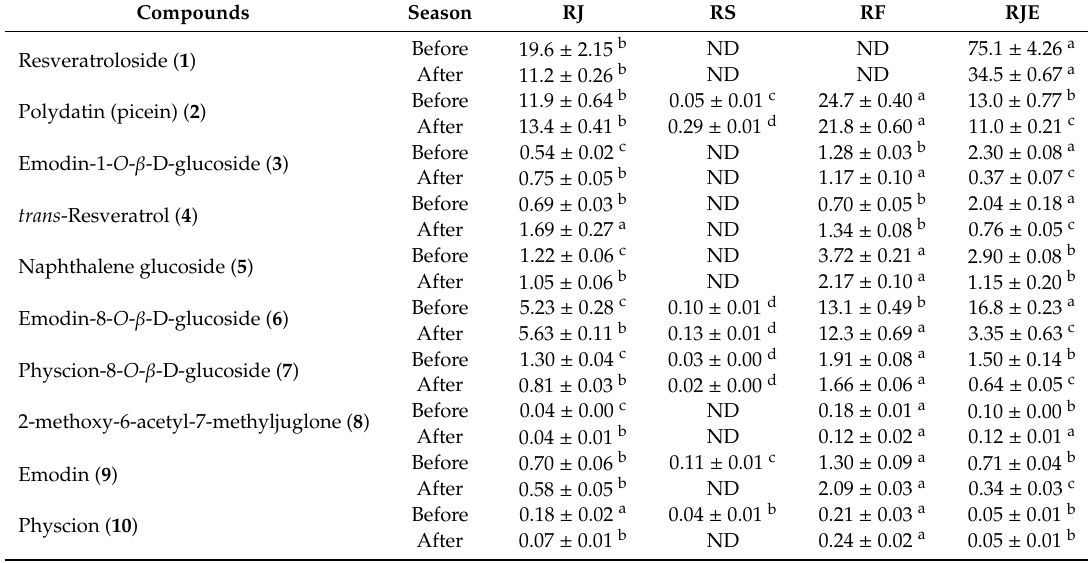
Data were expressed as mean ± SD (mg/g dry weight) ( n = 3). The different upper letters in the same line indicate significant differences ( p < 0.05) among the samples.